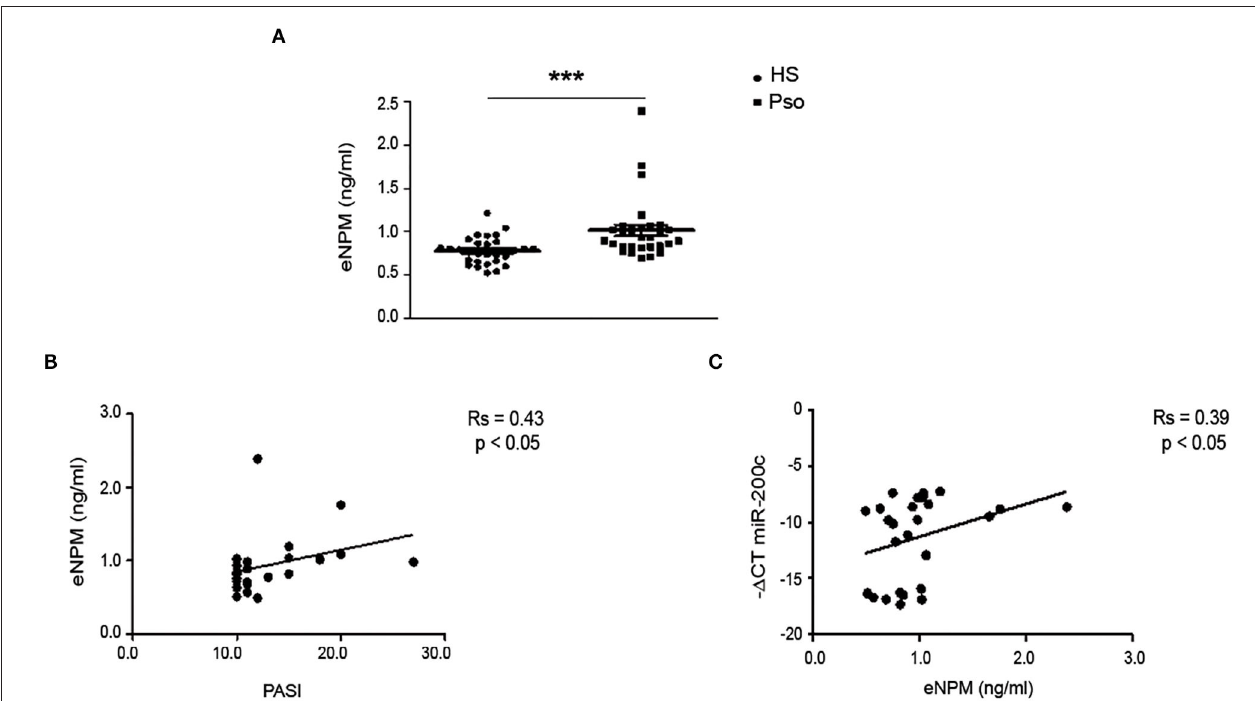
FIGURE 7 | eNPM is increased in plasma of Pso patients and positively correlates with PASI and miR-200c. (A) Plasma of healthy control subjects (Ctrl) and psoriatic patients (Pso) was assayed for eNPM by ELISA (A) eNPM level was increased in Pso compared to Ctrl (Mann–Whitney test) ( *** p < 0.001). (B) Correlation analyses of eNPM levels with Psoriasis Area and Severity Index (PASI). (C) Correlation analyses of eNPM levels with miR-200c circulating levels (Spearman’s correlation test).